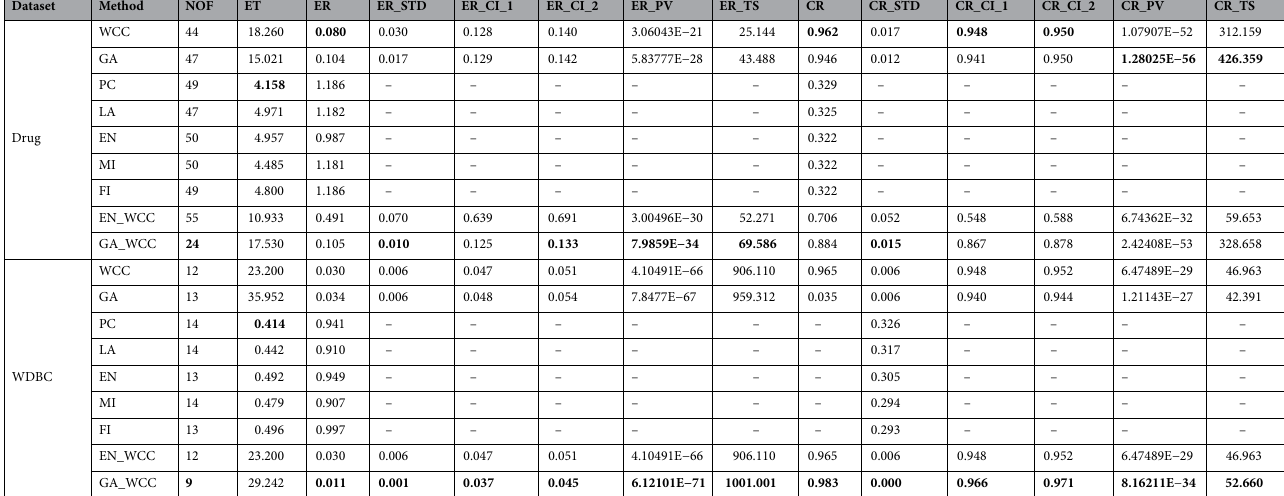
Table 7. Comparison of the methods on the regression-based datasets. The best outcomes have been highlighted. WCC, world competitive contests algorithm; GA, genetic algorithm; PC, Pearson correlation; LA, Laplacian score; EN, entropy; MI, mutual information; FI, Fisher score; NOF, number of features; ET, elapsed time; ER, error; STD, standard deviation; CI, confidence interval; TS, test statistics; PV, p-value; CR, correlation; 1, indicates low bound of confidence interval; 2, indicates high bound of confidence interval.